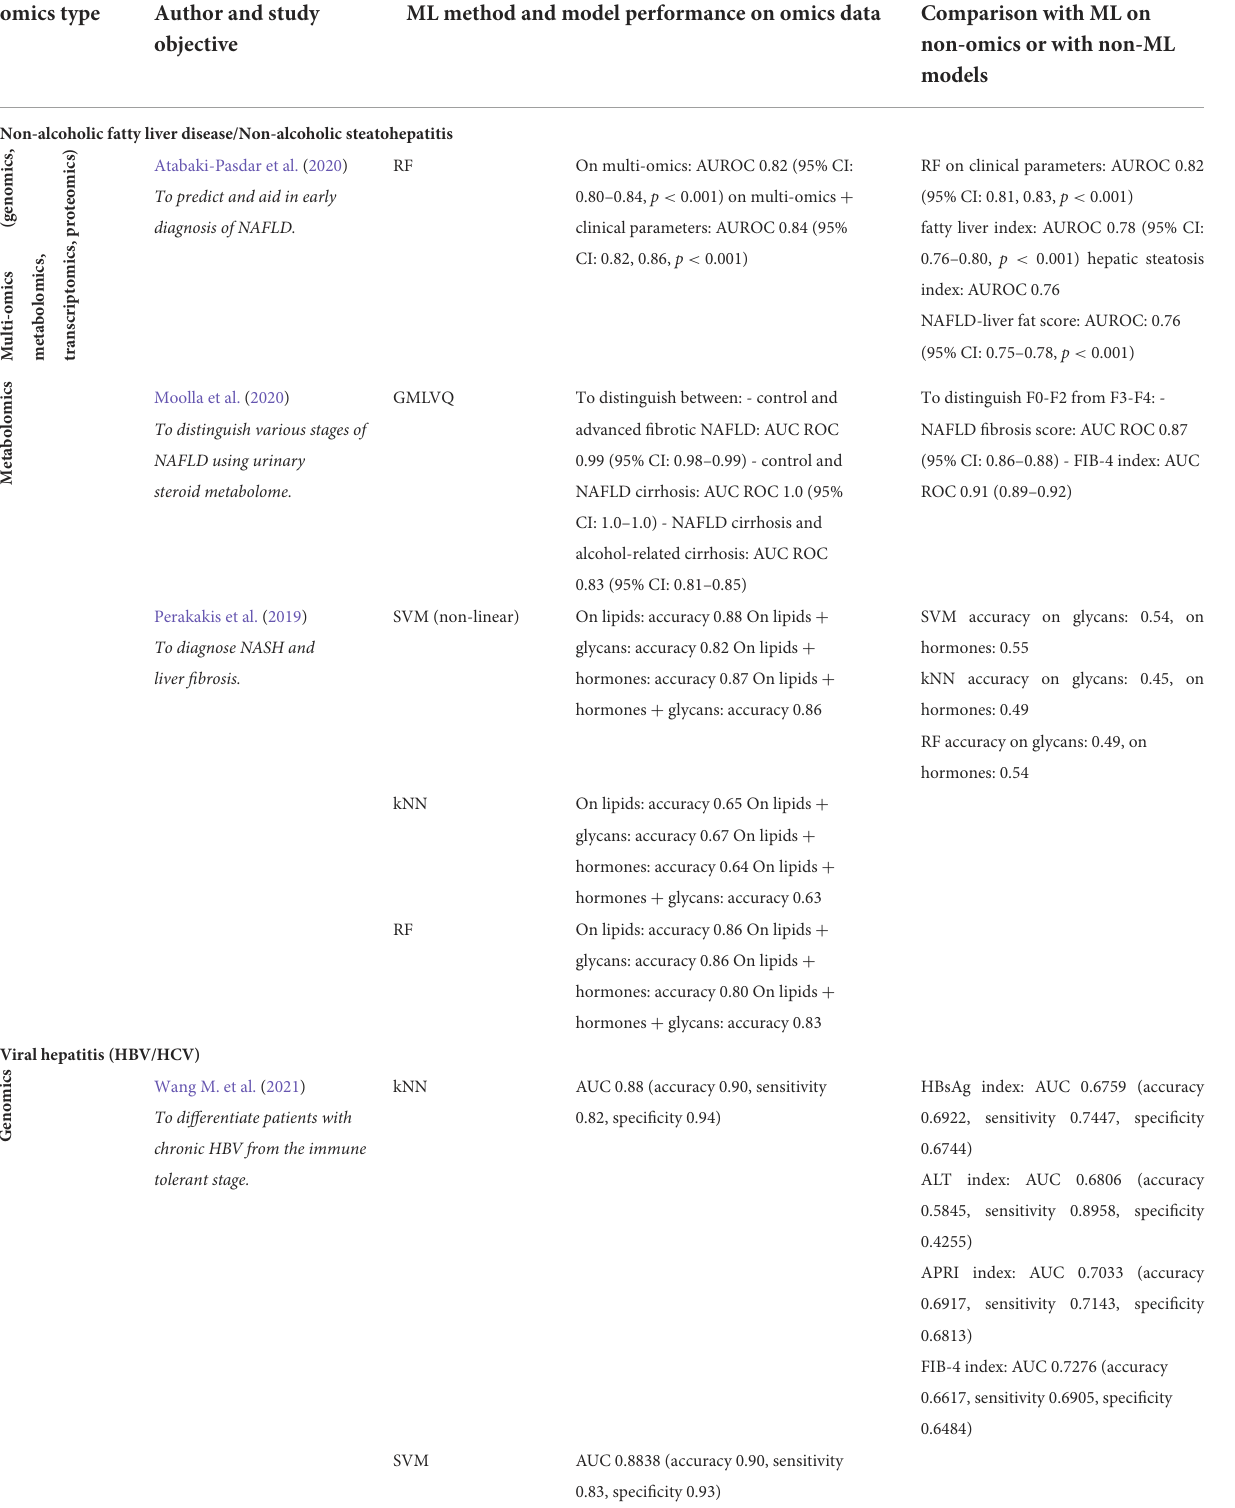
TABLE 2 Selected studies that performed comparison of ML methods and their performance to models using only clinical parameters, biomarkers or single features. omics type ML method and model performance on omics data Comparison with ML on